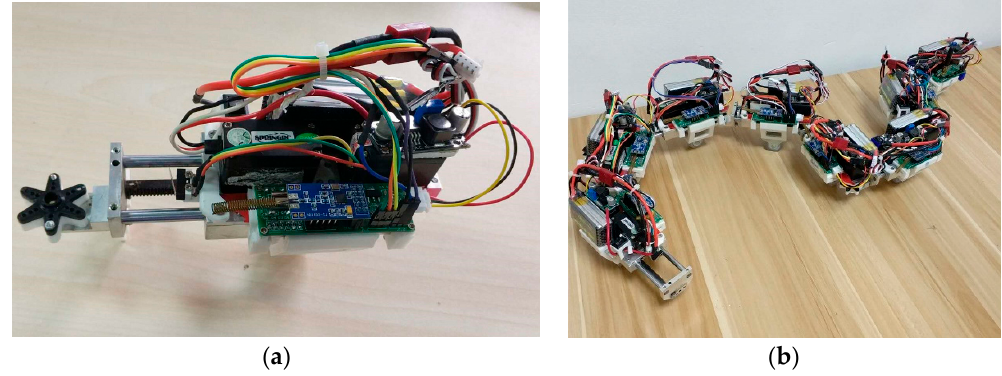
Figure 8. ( a ) Single snake-like robot module. ( b ) Connection of the snake-like robot module.